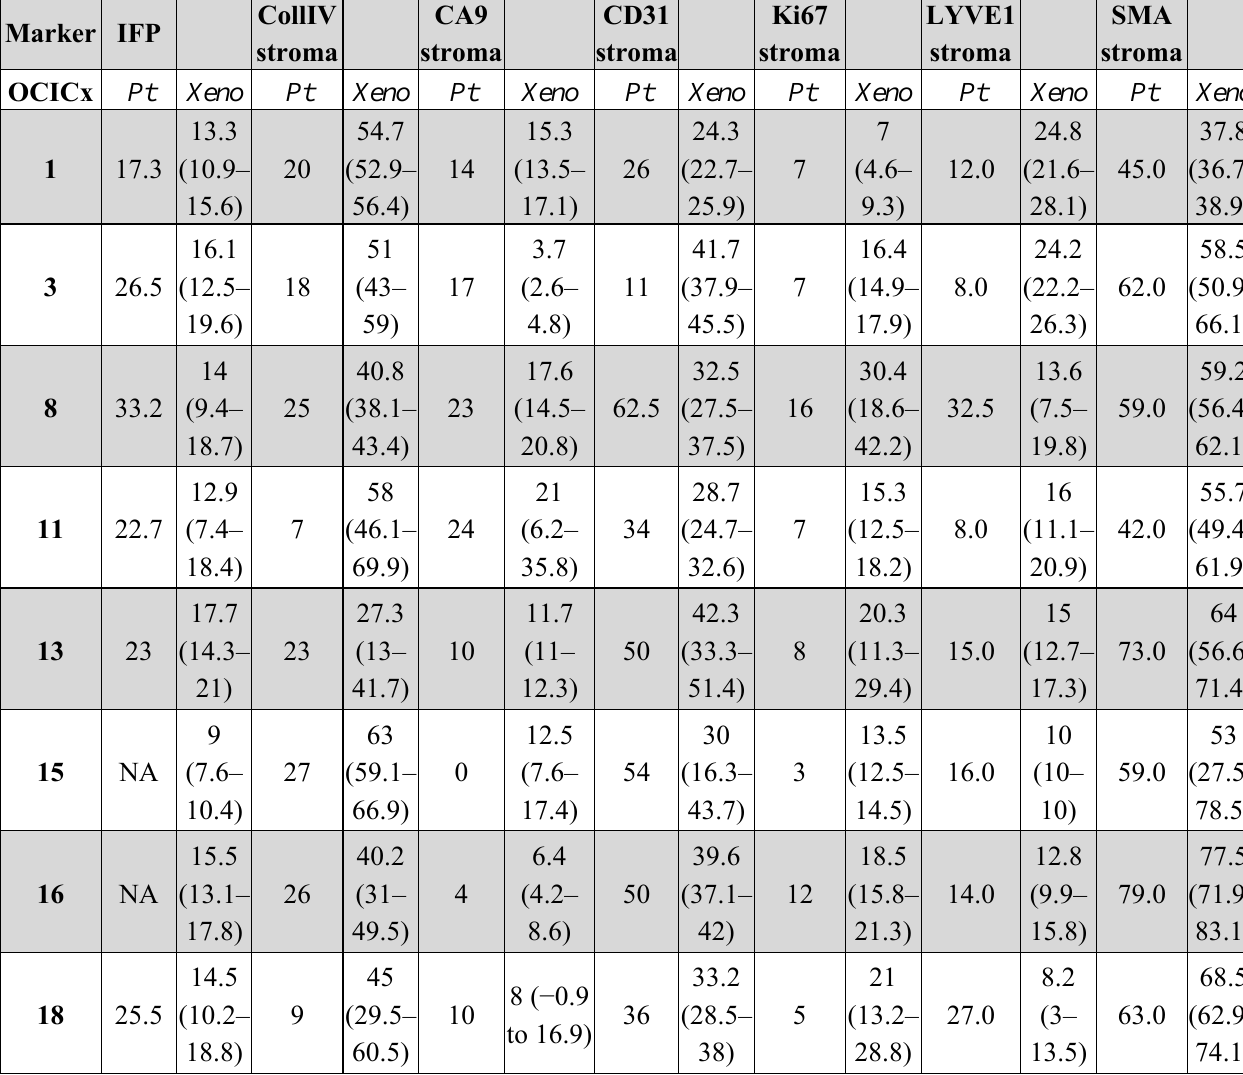
Supplementary Table 3. Percent labelling for IHC markers for passage 3 xenografts (mean ±SE) and matching biopsies (single values) measured in stroma ( A ) and tumor ( B